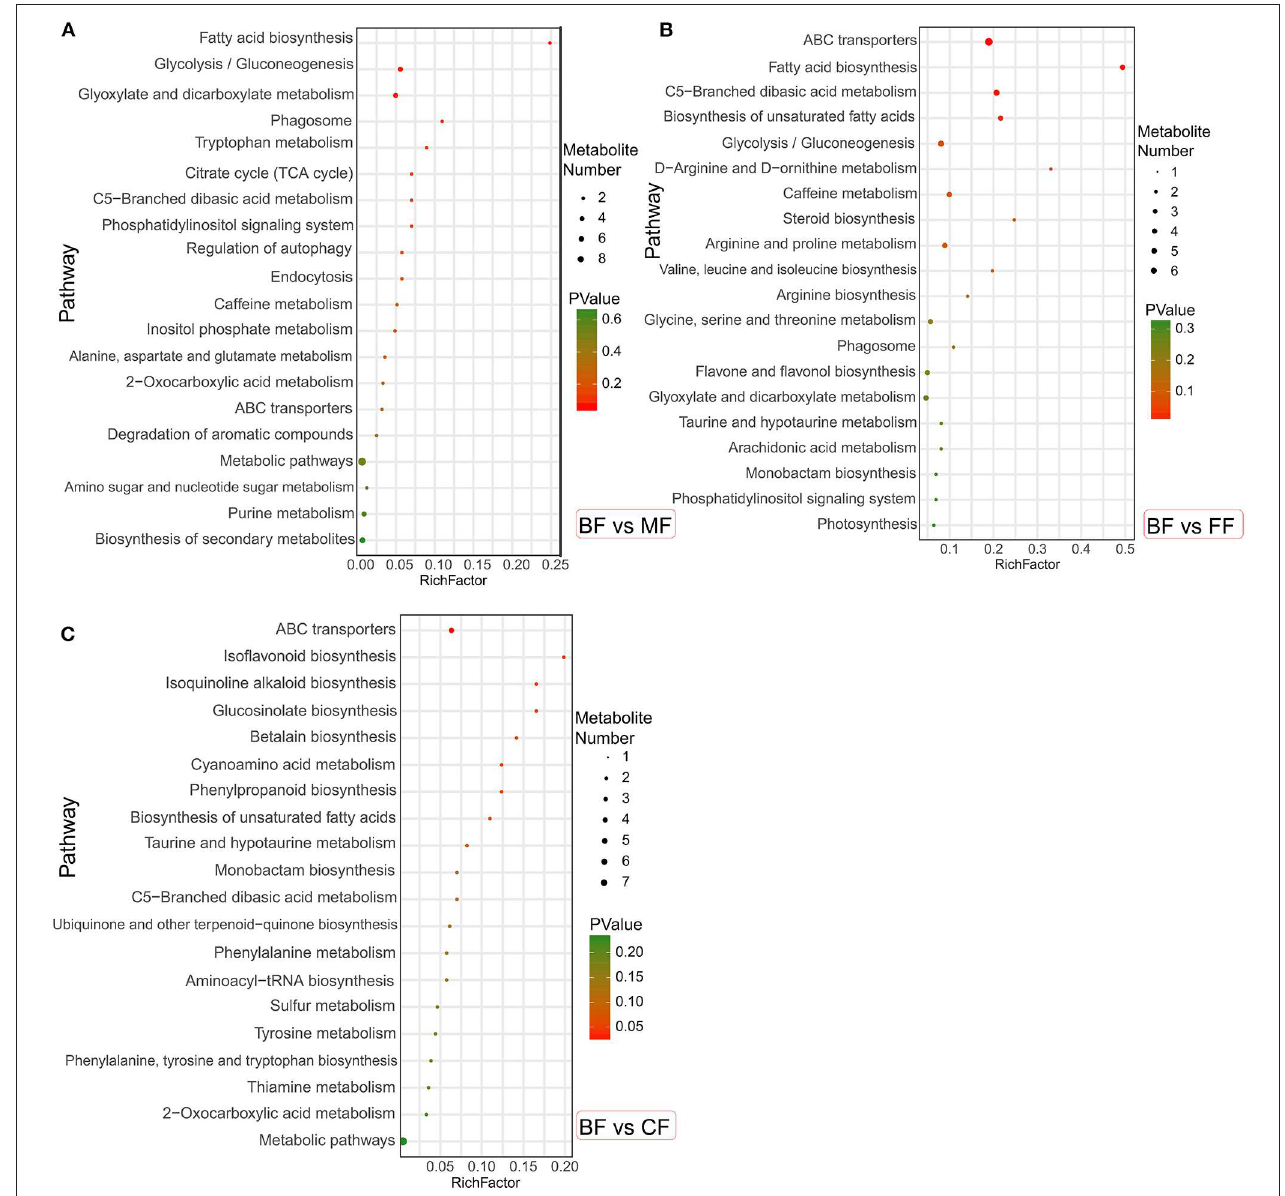
FIGURE 6 | The bubble diagrams of metabolic pathways in level 3. (A) The mixed-fed (MF) group vs. the breastfed (BF) group. (B) The formula-fed (FF) group vs. the BF group. (C) The complementary food-fed (CF) group vs. the BF